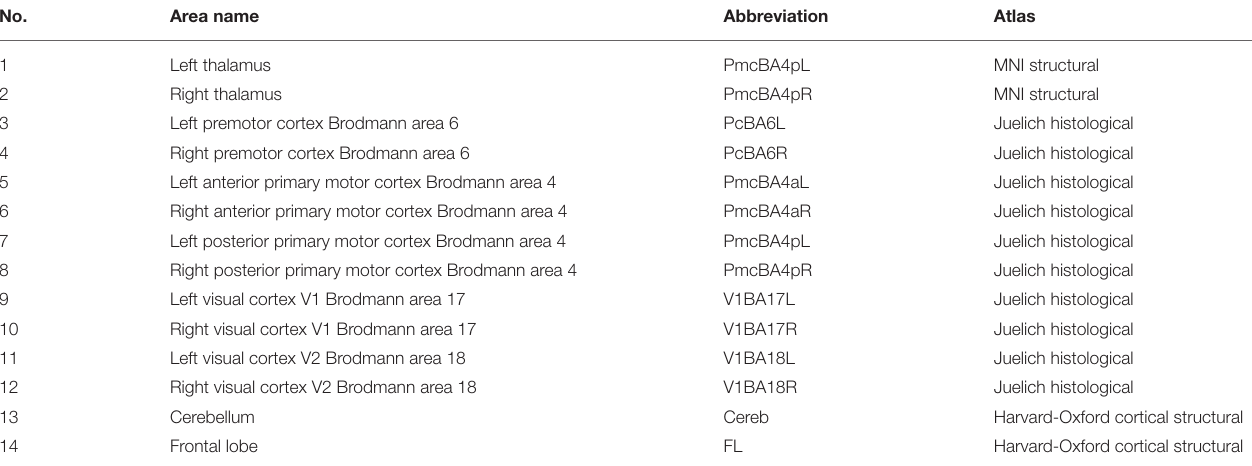
TABLE 1 | All region of interest included in connectivity